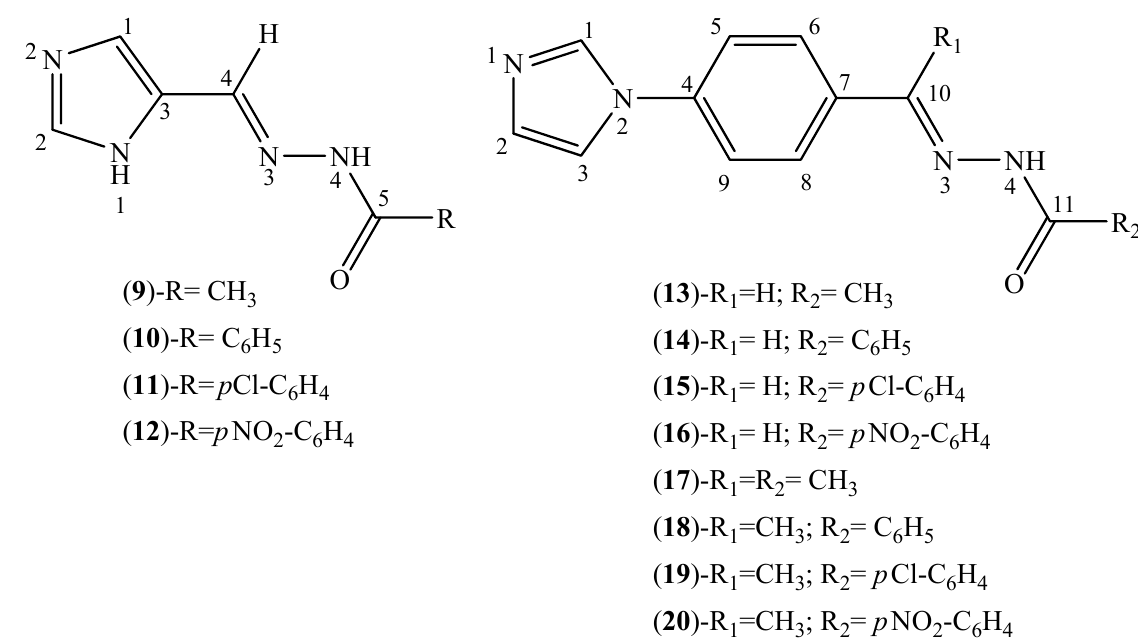
Figure 3. Generic representation for imidazole-derived